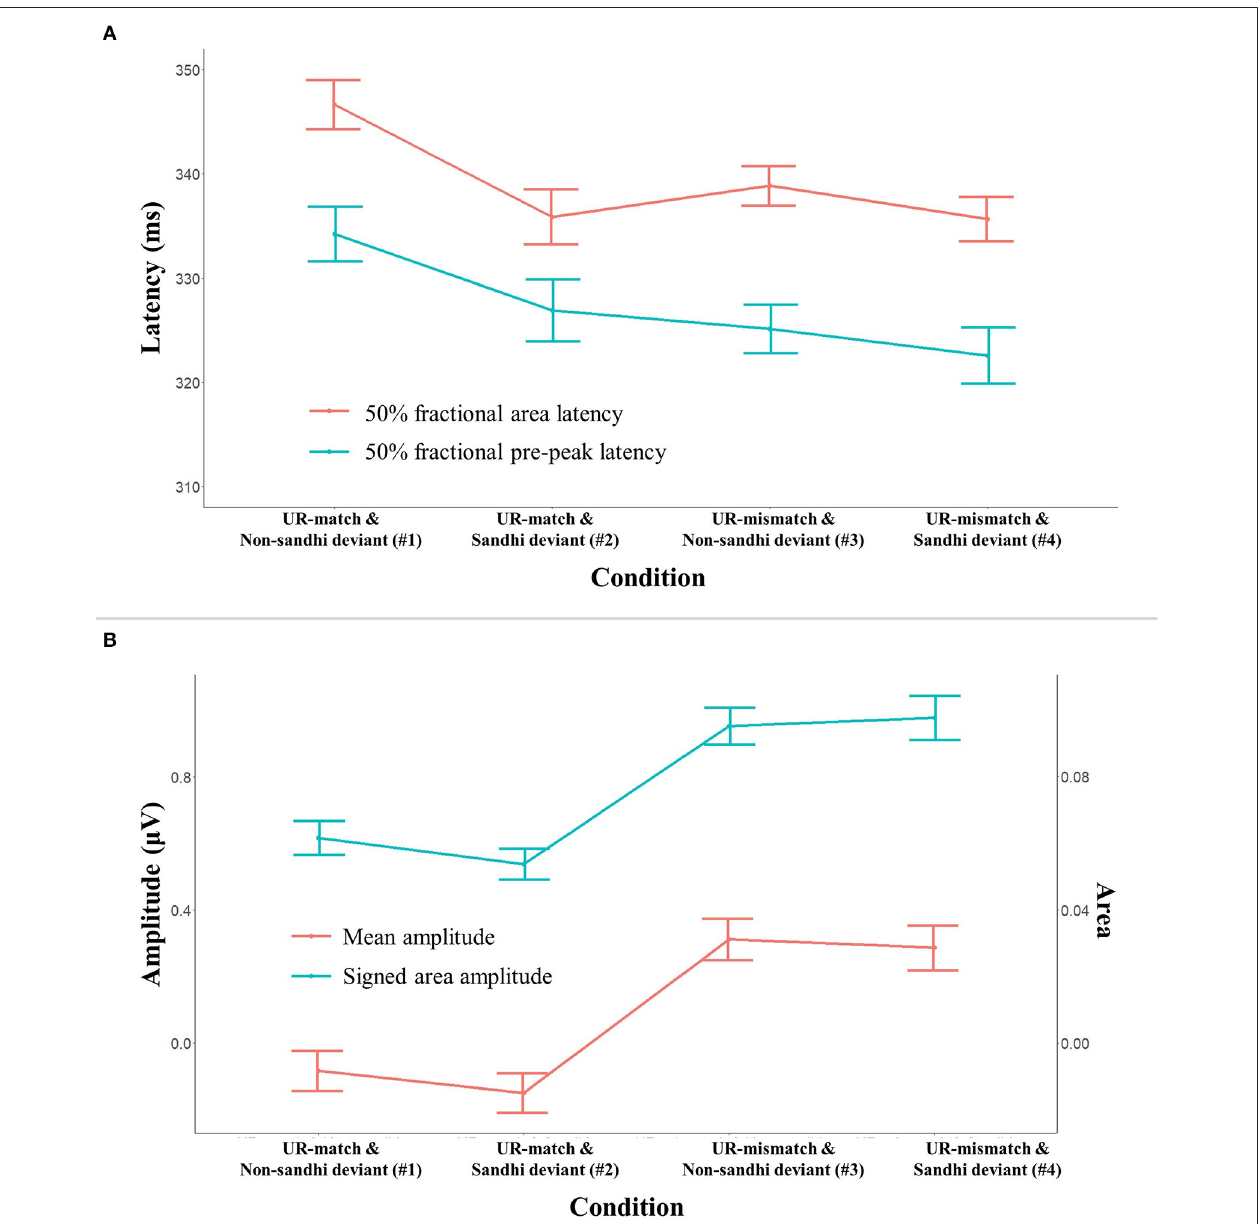
FIGURE 6 | Latency (upper panel) and amplitude (lower panel) measures for the S1-S2 transitional positivity. The error bars indicate 95% confidence interval (95% CI). Panel (A) shows two latency measures (50% fractional area latency, 50% fractional pre-peak latency) as a function of experimental condition. Panel (B) shows two amplitude measures (mean amplitude, signed area amplitude) as a function of experimental